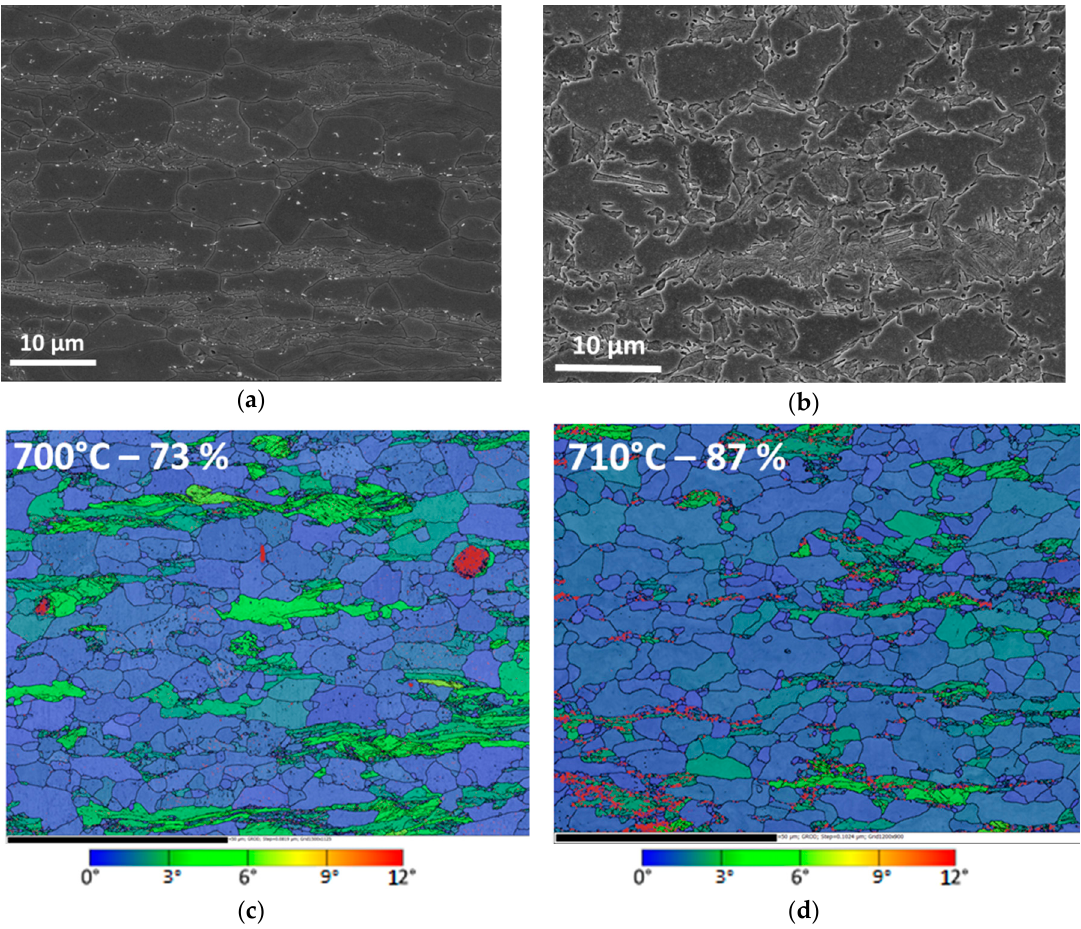
Figure 5. SEM/ESBD observations of the microstructure of studied steel after interrupted heating sequence ( a ) at 700 °C, ( b ) at 800 °C, ( c ) at 700 °C, and ( d ) at 710 °C, respectively. (a,b) are SEM micrographs after picral and metabisulfite etching to reveal grain boundaries and martensite, respectively. (c,d) are EBSD maps of the Grain Orientation Spread (GOS).